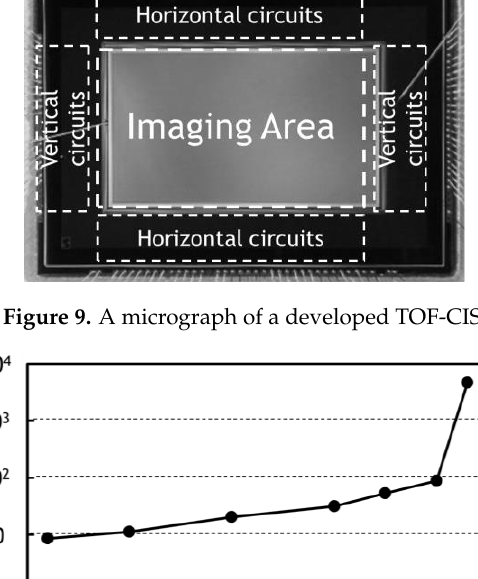
Figure 9. A micrograph of a developed TOF-CIS.